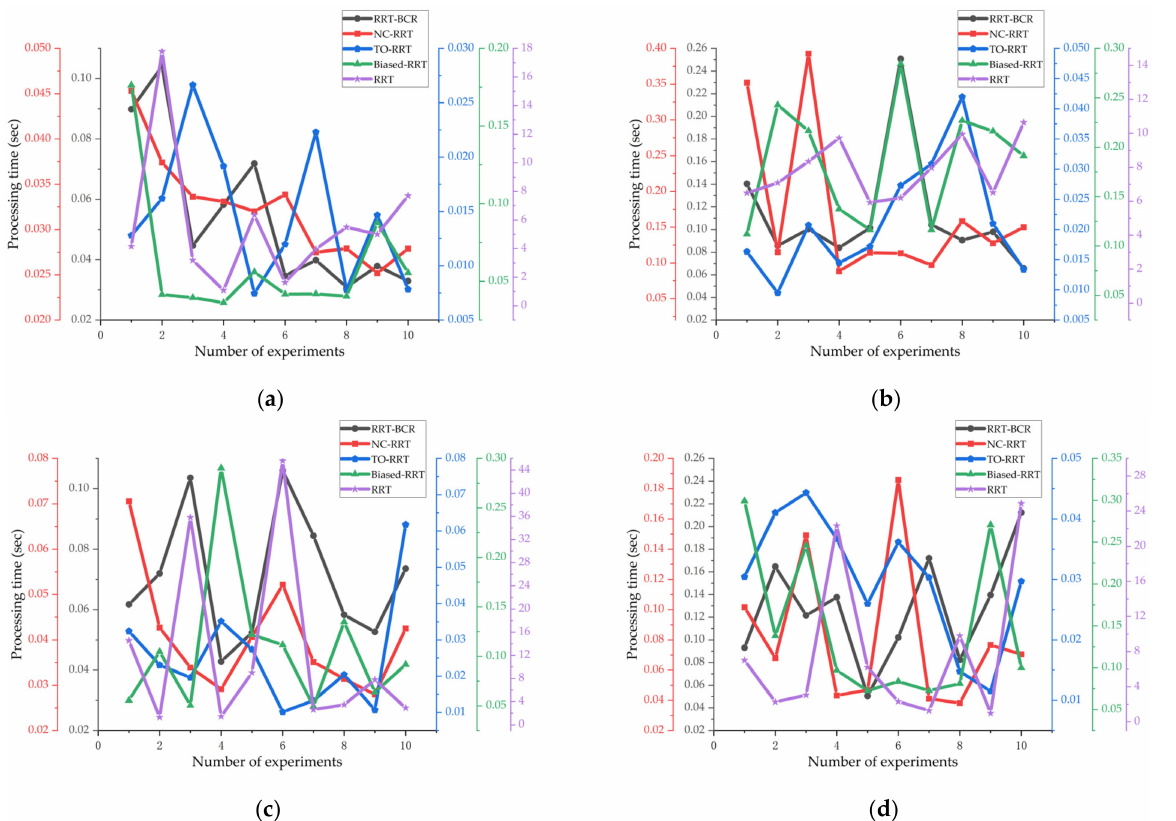
Figure 11. The running times of the RRT algorithm, the biased-RRT algorithm with a target offset probability of 50%, the TO-RRT algorithm, the RRT-BCR algorithm, and the NC-RRT algorithm. ( a ) Multi-sphere environment; ( b ) Multi-rectangle environment; ( c ) Single-channel environment; ( d ) Multi-channel environment. Table 2. Experimental results of each algorithm in different